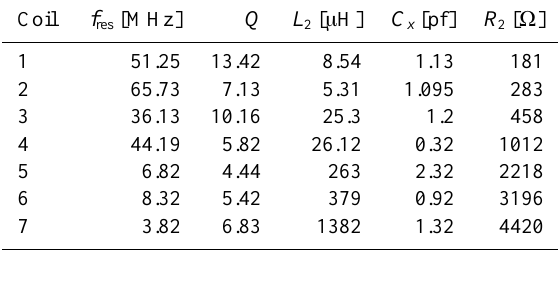
Table 4. Wirelessly characterized parameters of open-ended micro coils inductively coupled to an electrically small loop antenna.